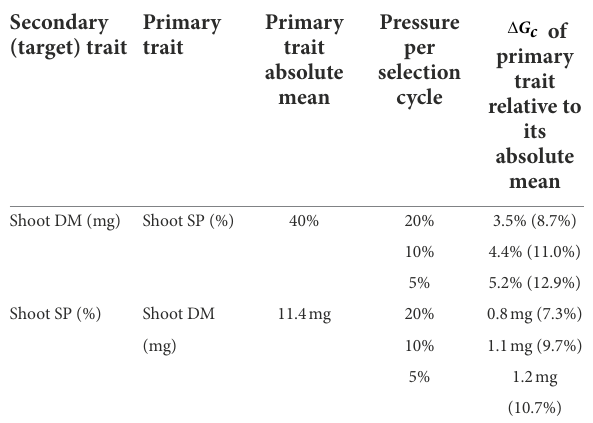
TABLE 4 Predicted correlated response ( D G c ) to selection per cycle for symbiotic traits Shoot DM and SP. Secondary Primary (target) trait